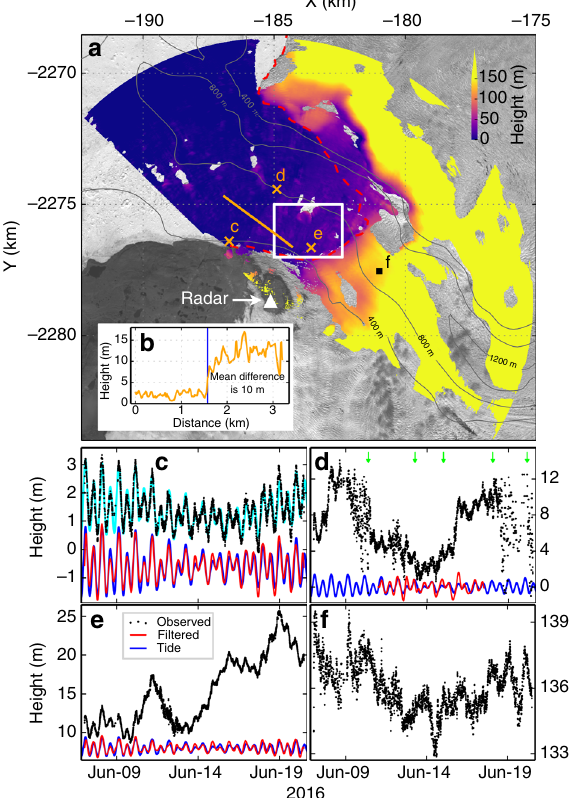
Fig. 2 TRI-measured elevations. a One-day median elevation map. Dashed red line indicates glacier front location; grey contour show bed elevation 18 of the main trunk; c – f mark locations of elevations shown in panels below; white box outlines area shown in Fig. 5a – h; orange line marks elevation pro fi le shown in b . c – f Black dots show observed elevations; red lines show band-pass fi ltered data (0.8 < frequency < 4 cycle-per-day (cpd) passed) for selected periods, shifted for clarity; blue curves show predicted tidal heights 37 , shifted by the same amounts as red lines. Cyan color in c is the best fi tting curve to data, RMS of the residuals is 22 cm (Methods and Supplementary Fig. 3). Green arrows in d mark major calving-like